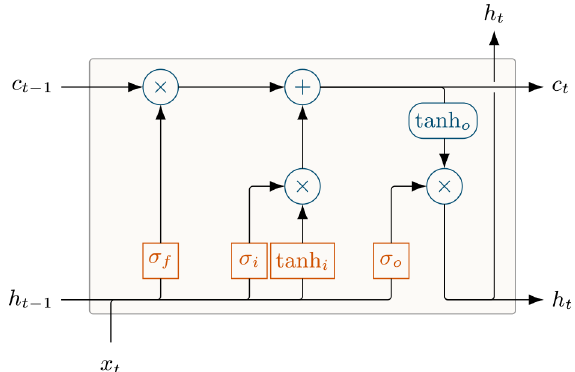
Figure 1. Schematic architecture of an LSTM cell with input x t , cell state c t , output h t , and activations for forget gate ( σ f ), input gate ( σ i , tanh i ), and output gate ( σ o , tanh o ). × and + denote element-wise multiplication and addition. Illustration derived from Olah,